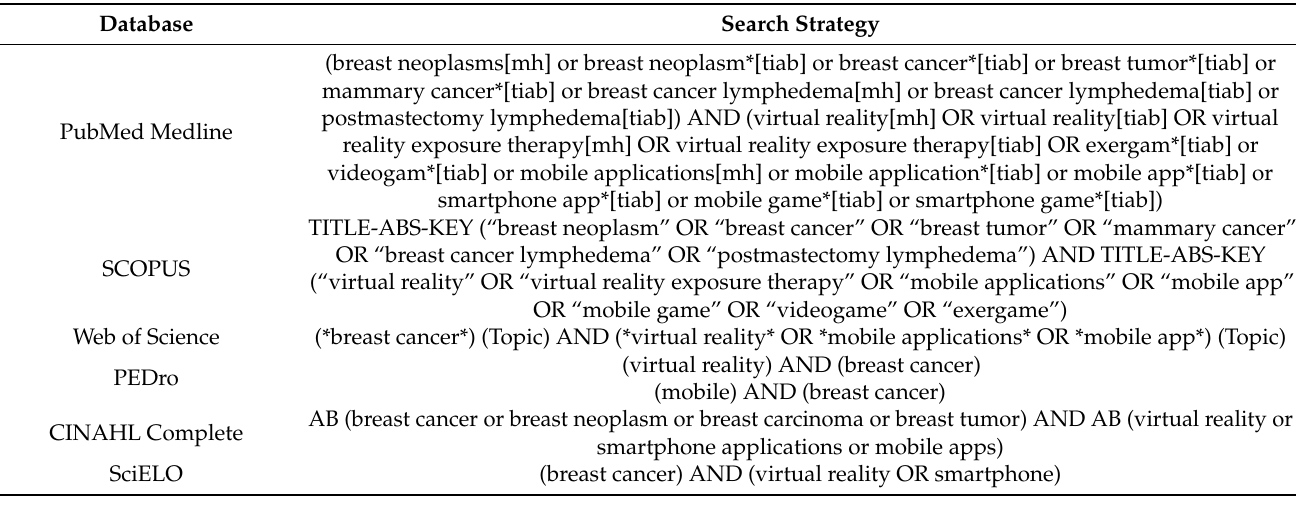
Table 1. Search strategies used for each